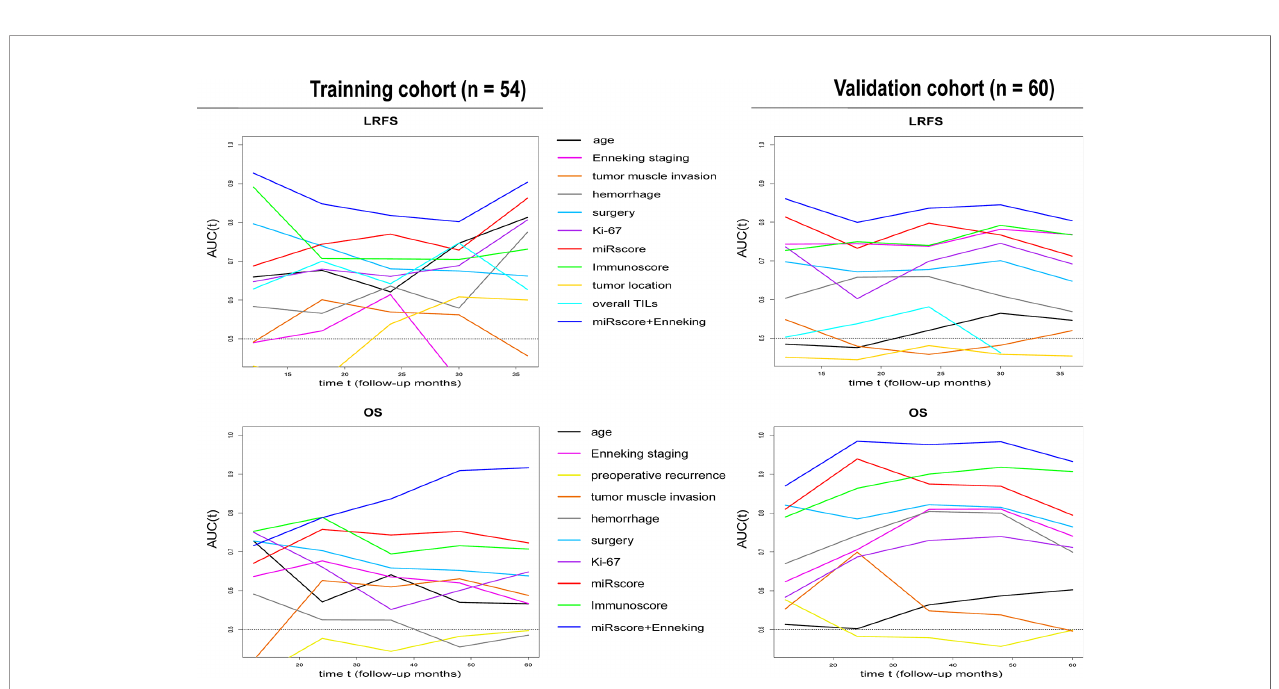
FIGURE 6 | Time-dependent sensitivity and speci fi city derived AUCs show the predictive performance of miRscore plus Enneking staging, miRscore, Immunoscore, Enneking staging and other known clinicopathological factors for LRFS and OS prediction in the training (left) and validation samples (right) at follow-up years 1 to 3 (for LRFS) or 1-5 (for OS). AUC, area under the curve; miRscore, microRNA risk score; LRFS, local recurrence-free survival; OS, overall